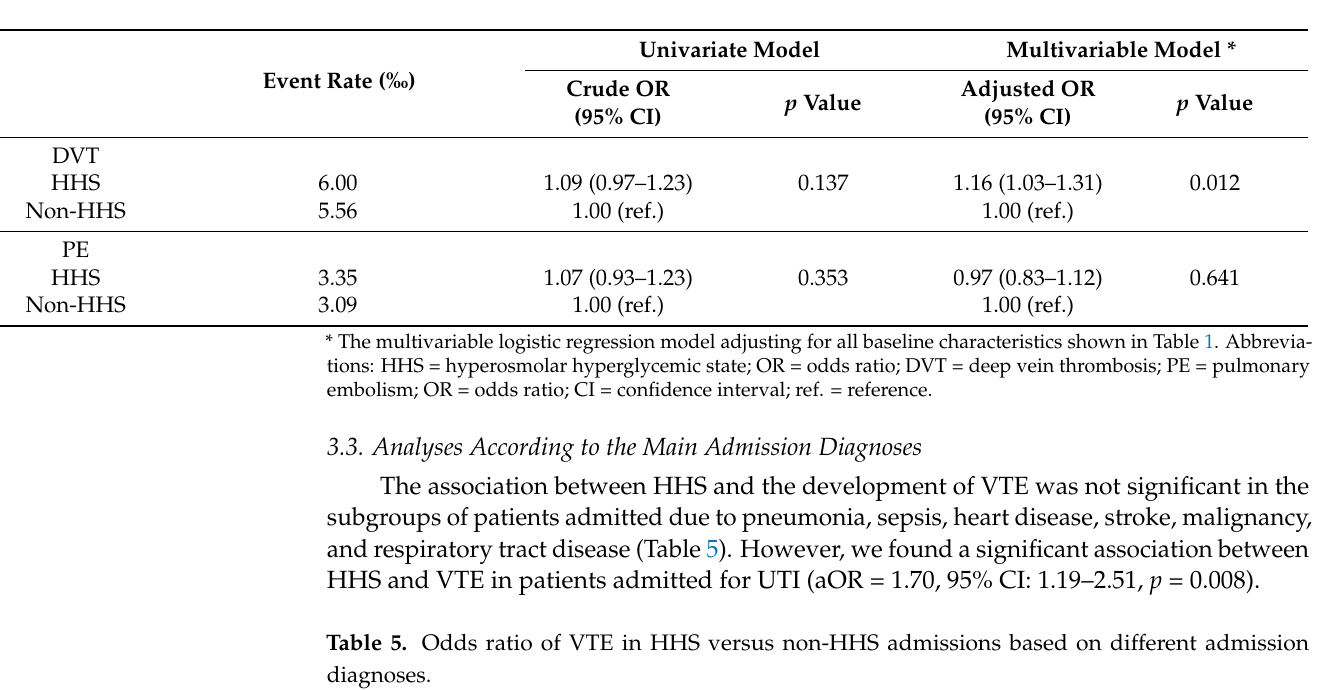
Table 4. Event rate and odds ratio of DVT and PE in HHS versus non-HHS admissions.